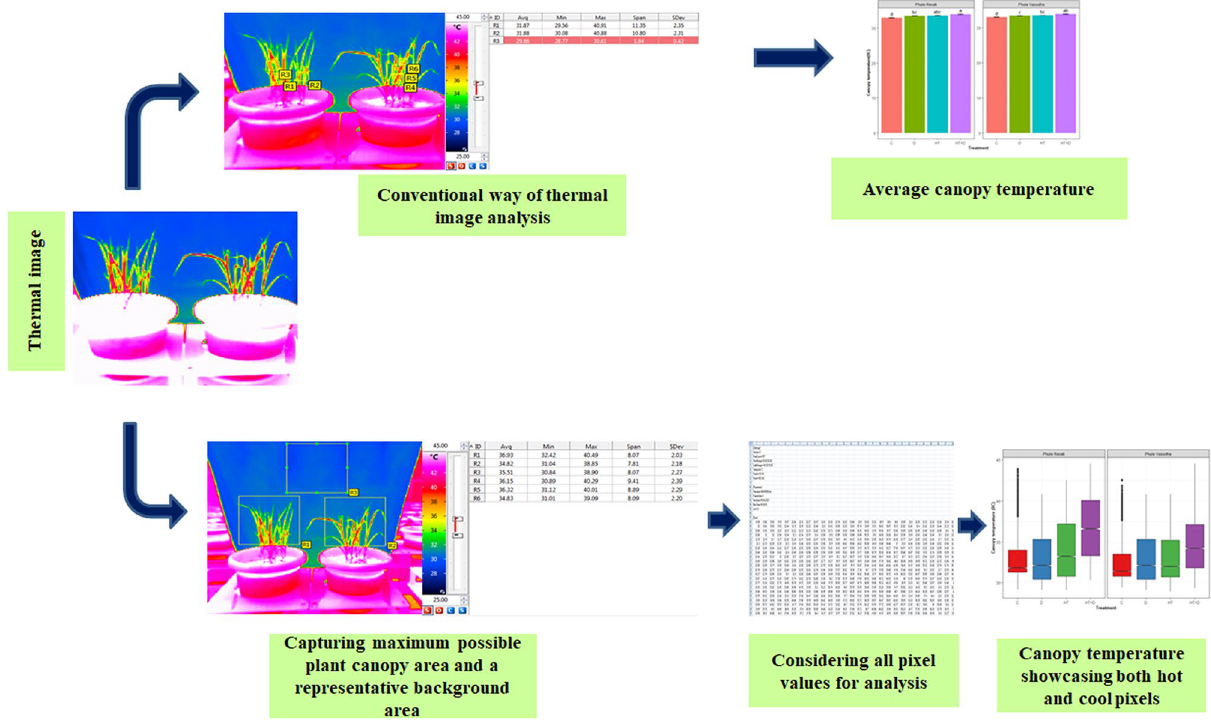
Figure 7. Conventional versus suggested way of analyzing thermal images of canopy